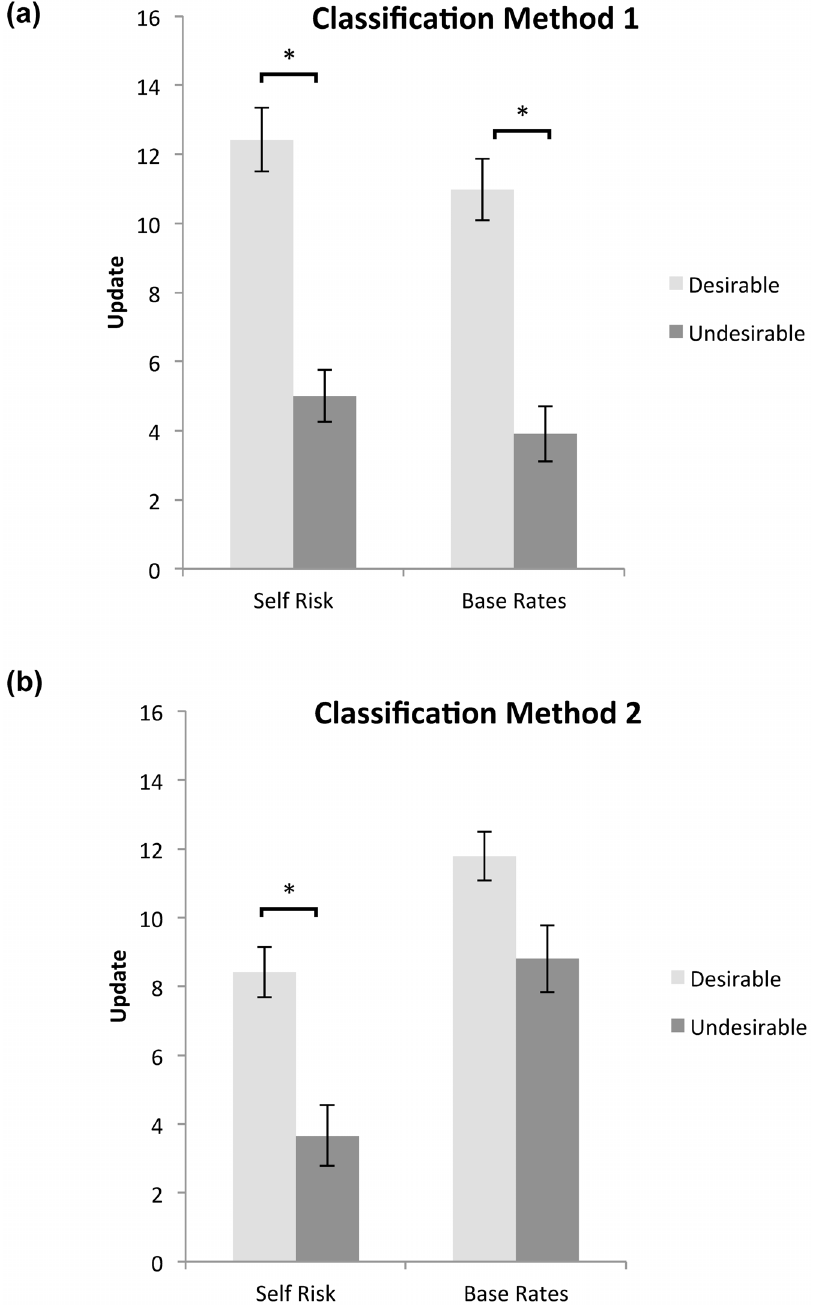
Figure 2. Update for self risk and base rates under different classifications of desirability. Participants update estimates of their self risk more when the information they received was desirable compared to undesirable. Participants update estimates of their base rates more when the information they received was desirable compared to undesirable under classification one but not under classification two after controlling for relevant covariates. Update calculated as first minus second estimation for desirable trials and the reverse for undesirable trials (positive values therefore indicate a move towards the information presented). Error bars are SEM; *indicates statistical significance at a threshold of P , 0.05, two tailed after controlling for all relevant covariates. Trials classified as desirable when the participant overestimated the probability of the event occurring and undesirable when the participant underestimated the probability of the event occurring: (a) to themselves relative to the provided base rate; (b) in the population relative to the provided base rate. Estimation Errors: As the magnitude of the update is likely to be provided) it is critical to examine for differences in the magnitude related to the magnitude of the initial estimation error (i.e. the of the errors for desirable and undesirable trials. difference between the participant estimate and the information Under classification two there was a difference between desirable and undesirable estimation errors for self risk (t(31)